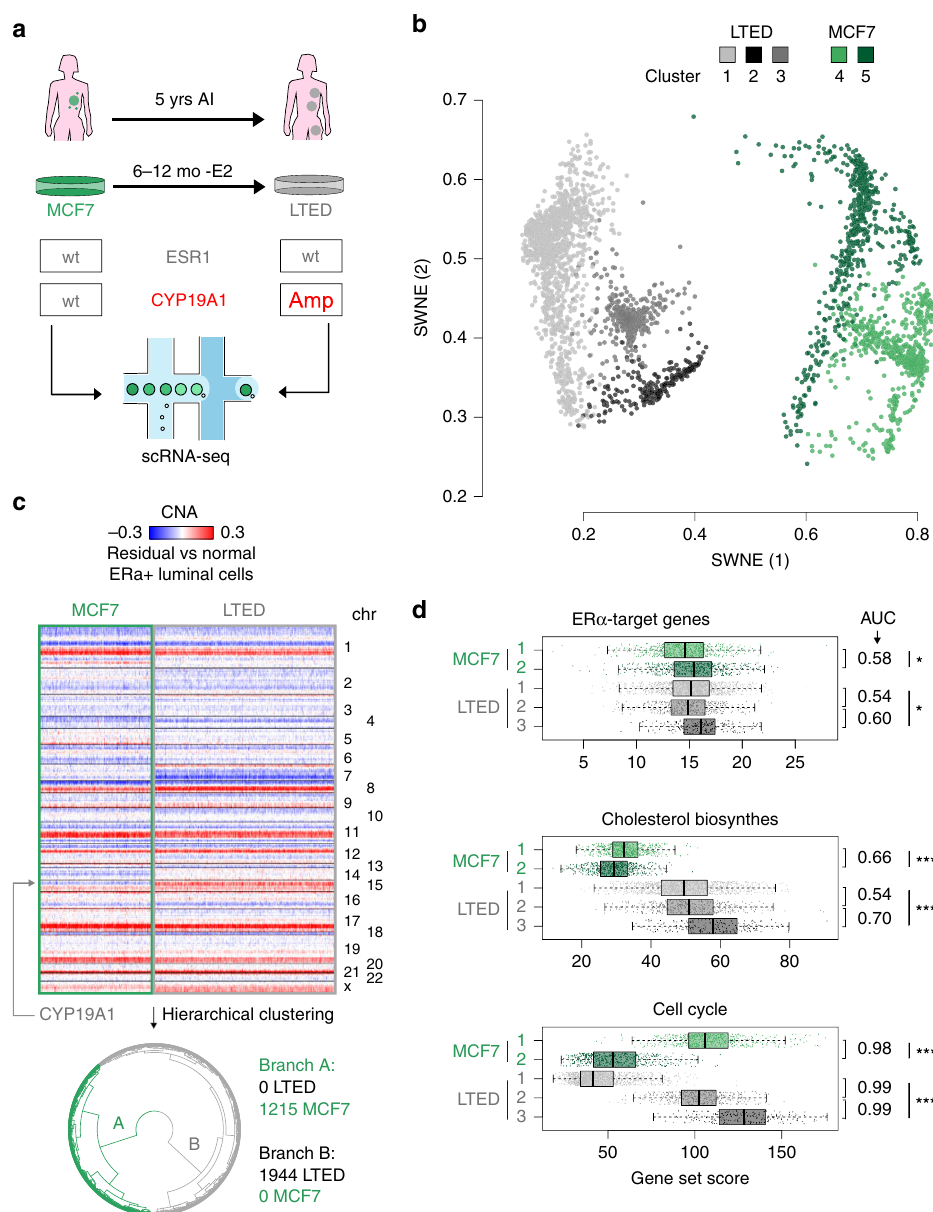
Fig. 1 Absence of fully resistant clones in treatment-naive cells. a Schematic representation of the in vitro approach (bottom), which mimics the development of resistance to aromatase inhibitors (AI) in patients. b Bi-dimensional representation of 3159 single-cell transcriptomes (1125 MCF7 and 1944 LTED) (SWNE; k = 16). c Copy number pro fi les of the cells shown in ( b ), as estimated from scRNA-seq pro fi les. The data shown as heatmap and as dendrogram (hierarchical clustering; Ward ’ s method; Euclidean distance). d Distribution of normalised expression levels for selected gene sets, by cluster of cells (as de fi ned in b ). Area Under the Curve calculated using the cluster with higher median gene expression as a positive set. Box plots show median, interquartile values, range and outliers (individual points). * p < = 1e-5, ** p < = 1e-10, *** p < = 2.2e-16 (Kruskal – Wallis (Fig. 2b; Supplementary Fig. 3d; twofold, p -value = 0.0029; Wil- cells (Supplementary Fig. 3j – l). In agreement with previous stu- coxon signed-rank test), suggesting higher chances of survival to dies 35 , CD44 high cells also showed cellular plasticity as they could ET for cells expressing CD44 in vivo. We next sought to inves- recapitulate the entire population, while CD44 low were capable of tigate if CD44 high cells can be also found at other active sites in generating only CD44 low cells (Supplementary Fig. 3f). breast cancer patients. Interestingly, we found substantial CD44 high cells in pleural effusions from all four patients exam- ined (Supplementary Fig. 3e). In line with this, the fraction of CD44 high cells was signi fi cantly increased in LTED (upper panels (Supplementary Fig. 4). Reconstitution experiments from sorted in Supplementary Fig. 3f, g). Extensive functional characterisation cells showed that CD44 GFP-high cells could recapitulate all the functional aspects of endogenous CD44 high cells, including of these cells demonstrated that MCF7-CD44 high cells were more invasive, more clonogenic and could form fi rst- and second CD44 GFP-low showed features of plasticity in fully resistant cells generation of mammosphere at higher ef fi ciency than CD44 low